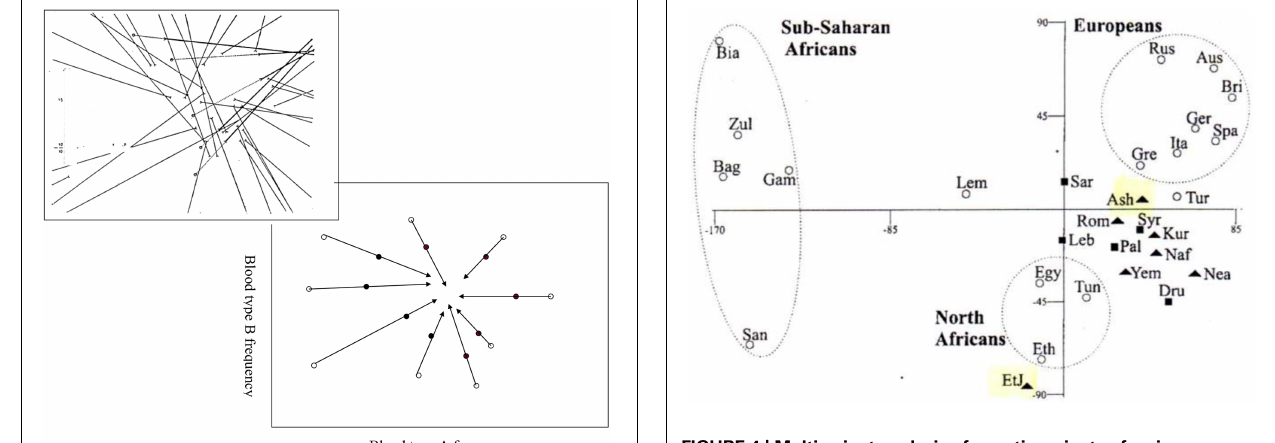
FIGURE 4 | Multivariant analysis of genetic variants of various populations, based on Y-chromosome hapolotype data (Hammer et al., 2000). Solid triangles represent Jewish populations, solid squares represent Middle Eastern